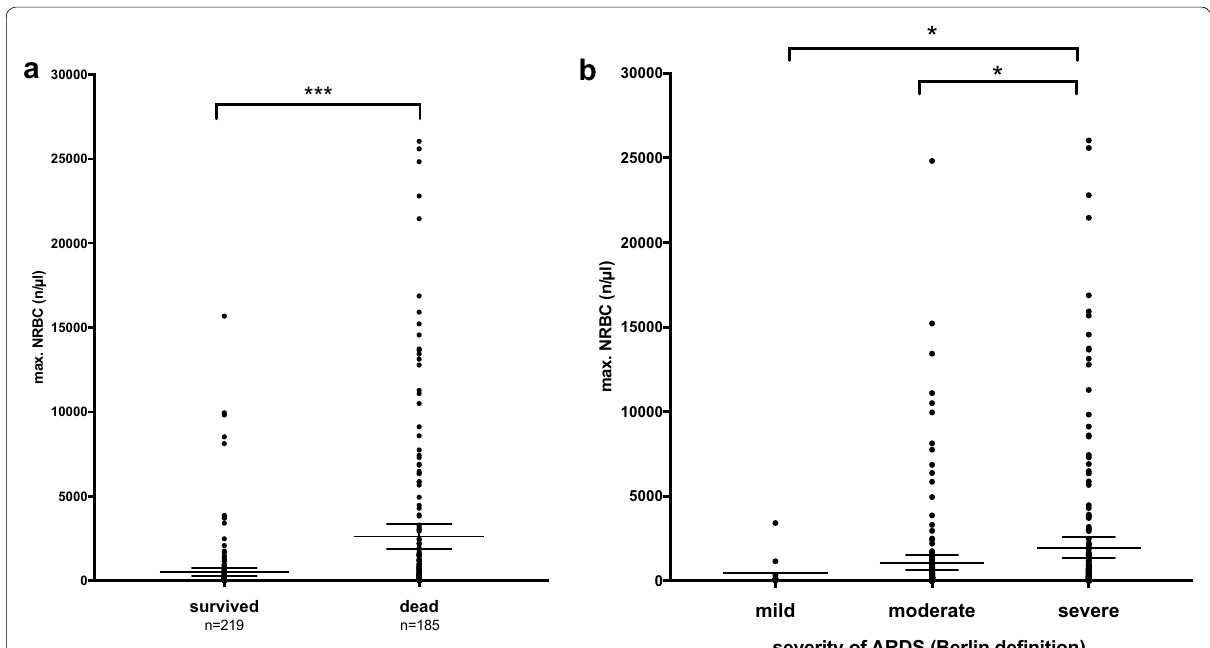
Fig. 1 Maximum concentration of nucleated red blood cells (NRBCs) in the blood of ARDS patients grouped by a survivors and non‑survivors and b severity of lung failure according to the Berlin definition of ARDS (mild, moderate, severe); n